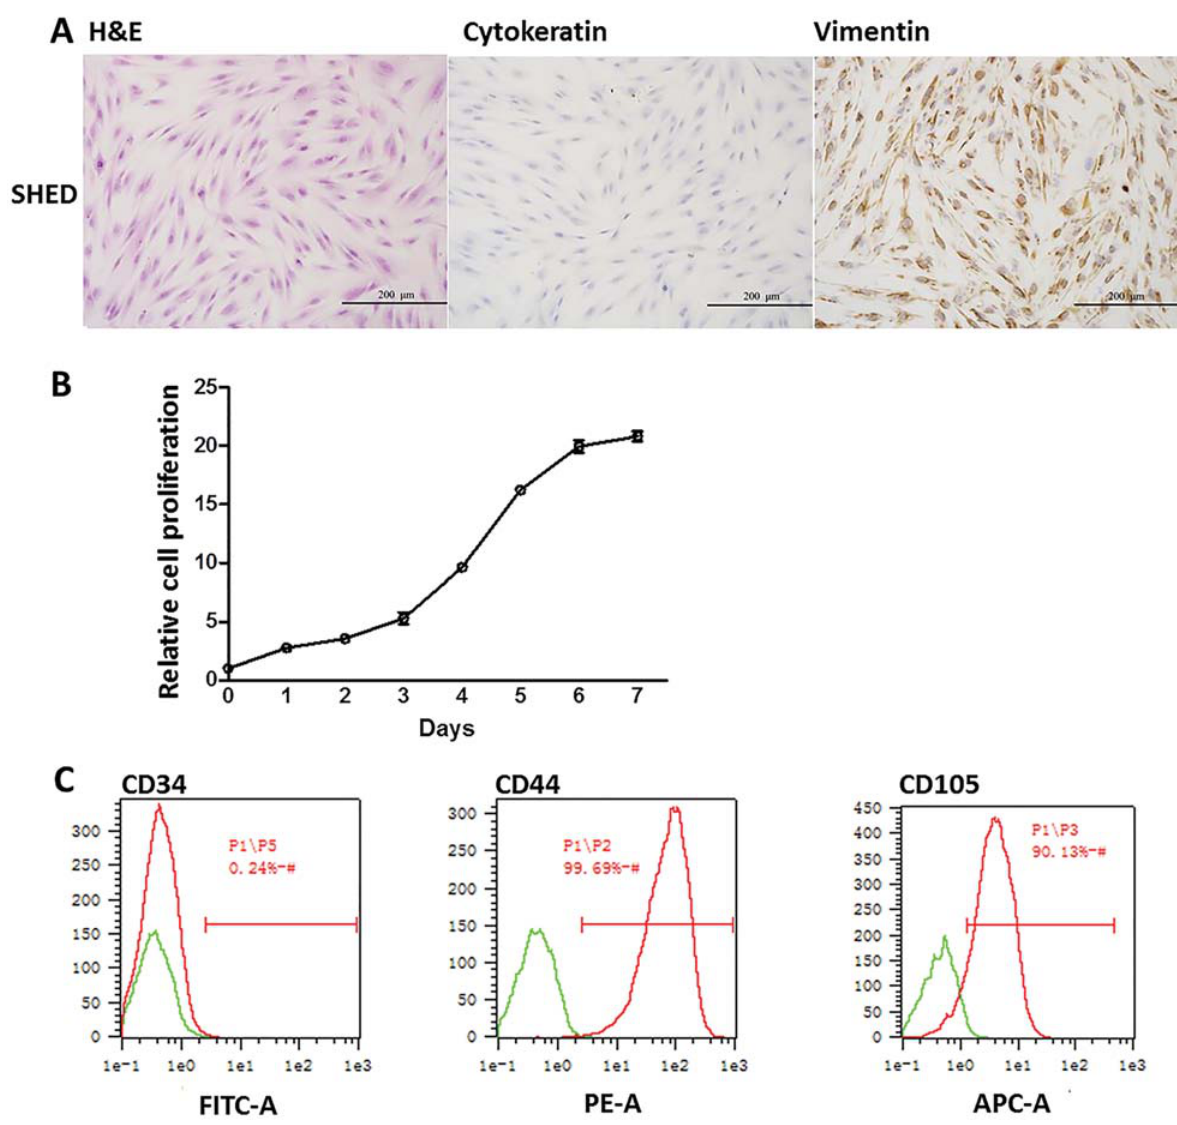
Figure 1. Photomicrographs of extracted stem cells from human exfoliated deciduous teeth (SHEDs) showing characteristics of mesenchymal stromal cells (spindle-like shape) with high proliferation activity. A , H&E staining of SHEDs and immunocytochemical staining of cell markers cytokeratin, vimentin, (cid:1) 200. B , SHEDs cell proliferation was quanti fi ed by CCK-8 assay for 1 – 7 days. Data are reported as mean percentages ± SD from three independent experiments. C , Flow cytometry analysis of cell surface markers CD34, CD44, and